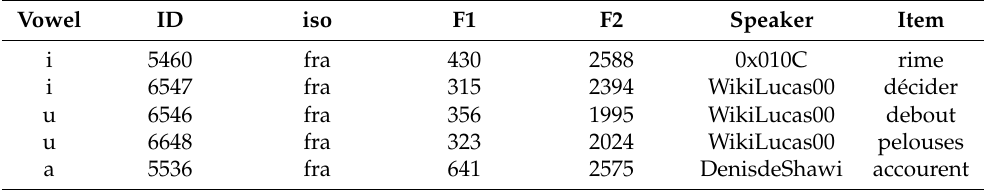
Table 2. An example of the data extracted and compiled from Lingua Libre. The rows represent occurrences of the vowels [a], [i], and [u] found in languages of the data set. Vowel ID iso F1 F2